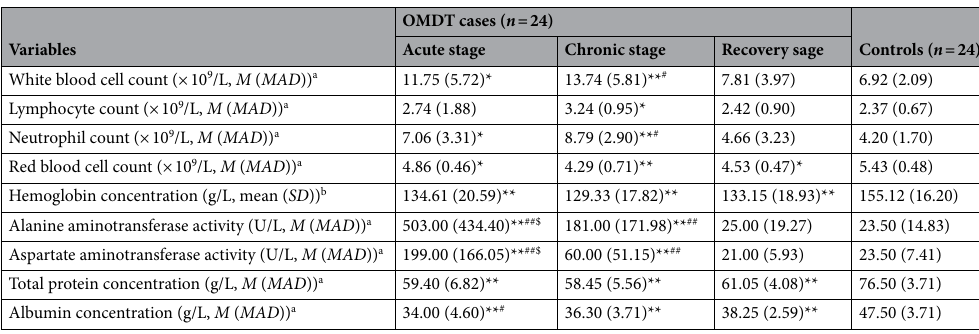
Table 2. Comparison of blood test indices between the groups. OMDT, occupational medicamentosa-like dermatitis due to trichloroethylene; M, median; MAD, median absolute deviation; SD, standard deviation. a Mann–Whitney U test with Holm’s adjustment. b ANOVA with Tukey’s HSD test. Compared with controls, * P < 0.05, ** P < 0.01; compared with cases in recovery stage, # P < 0.05, ## P < 0.01; compared with cases in chronic stage, $ P < 0.01.